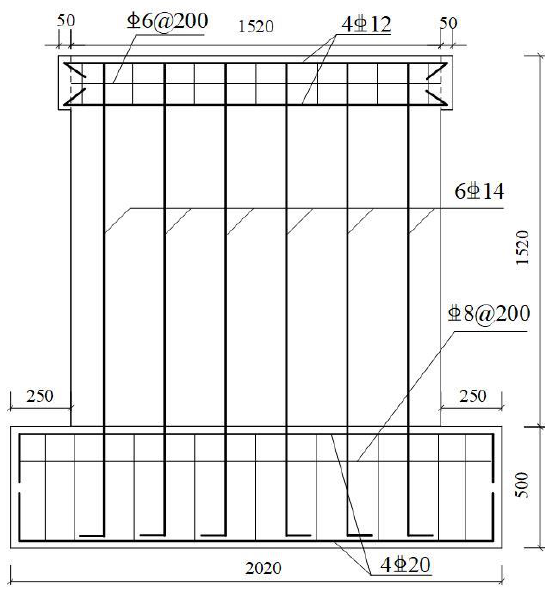
Figure 3. Specimen rebar location.